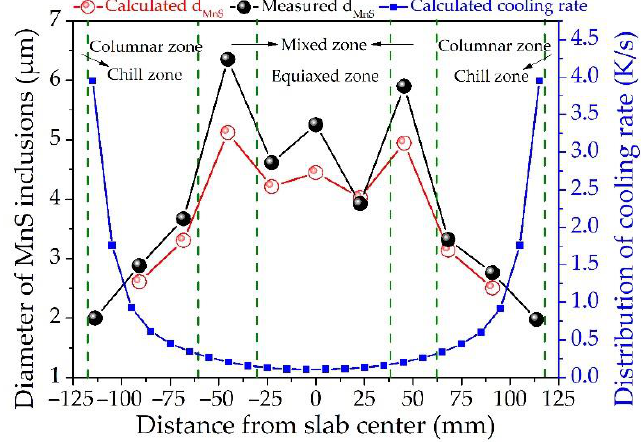
Figure 10. Distribution of the calculated and measured diameters of MnS inclusions, calculated cooling rate along the slab thickness of the medium carbon structural steel 45#.